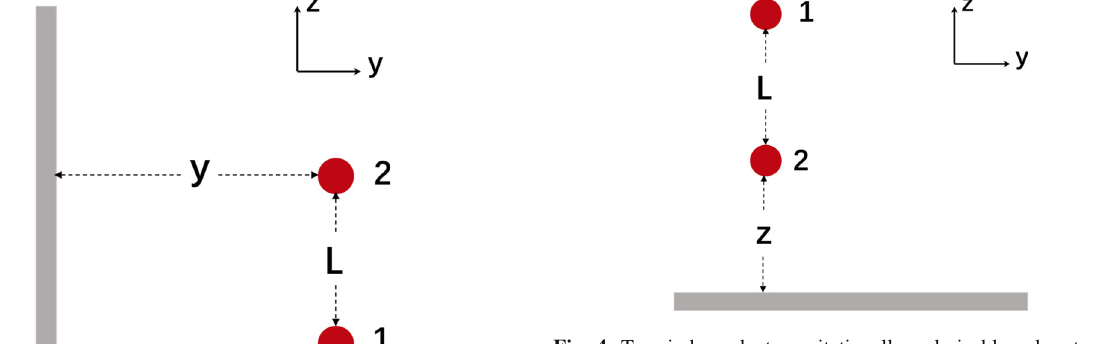
Fig. 4 Two independent gravitationally polarizable subsystems are placedonthe z -axiswithaseparation L .ADirichletboundaryislocated in the xoy plane, and the distance to the closer one is